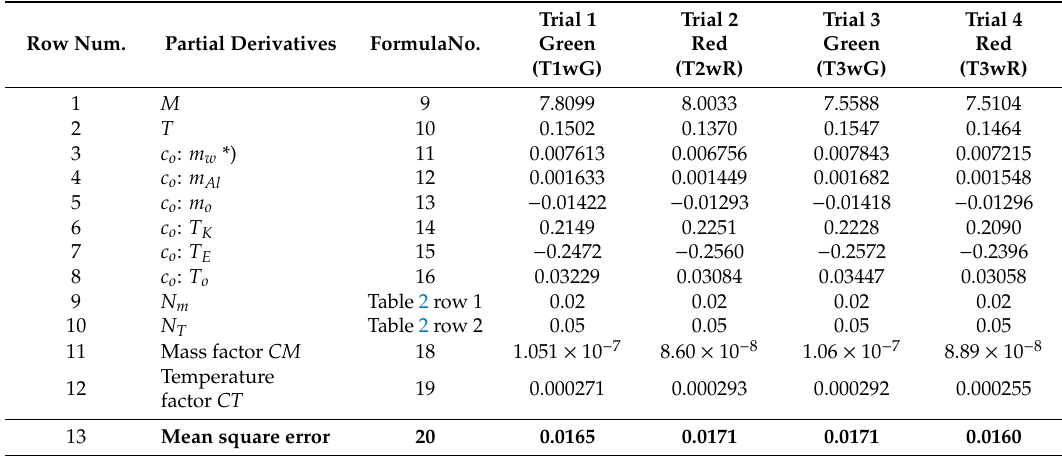
Table 3. Summary of the values of partial derivatives for measurements as in Table 1 and calculation of the error. Distilled water as a heating